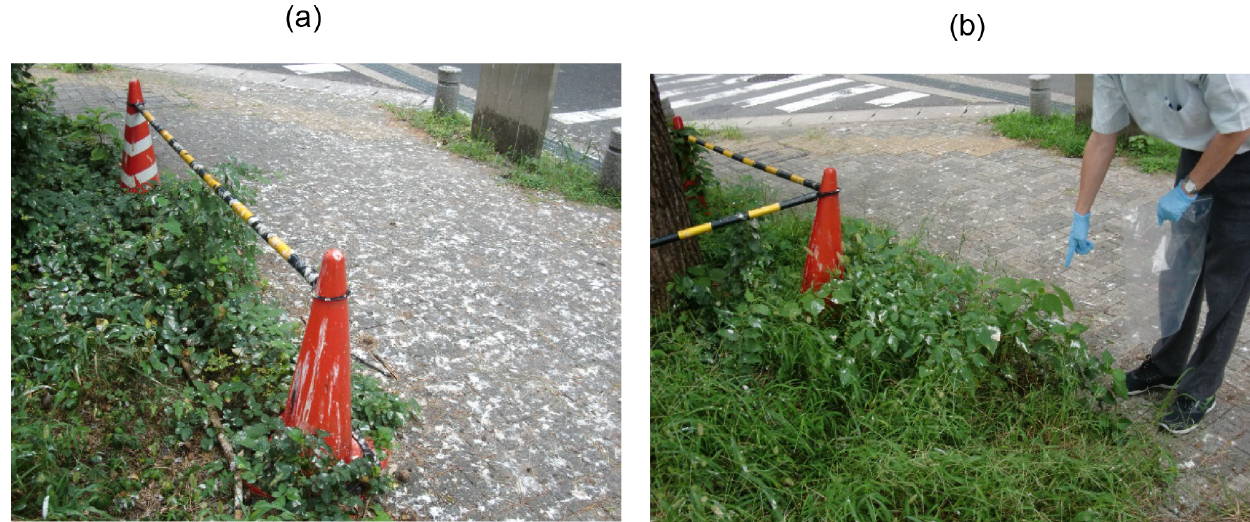
Figure A1. Crow droppings (photographs taken at the same place on a 28 July 2018; b 17 October 2019) in front of the Environmental Studies Hall of Nagoya